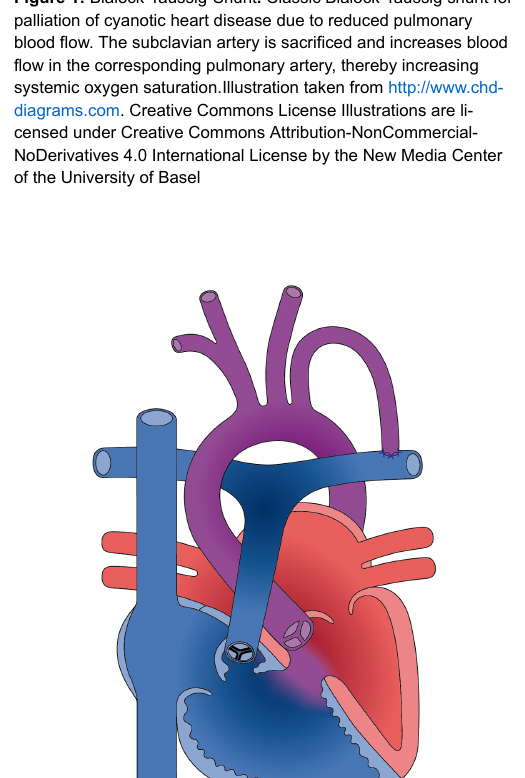
Figure 3: Survival rates (first year) with congenital heart disease (CHD) over different decades. The most remarkable increase in survival was observed in children with complex CHD, from 20% for children born in the 1950s to 90% for children born in the past 20 years [2,